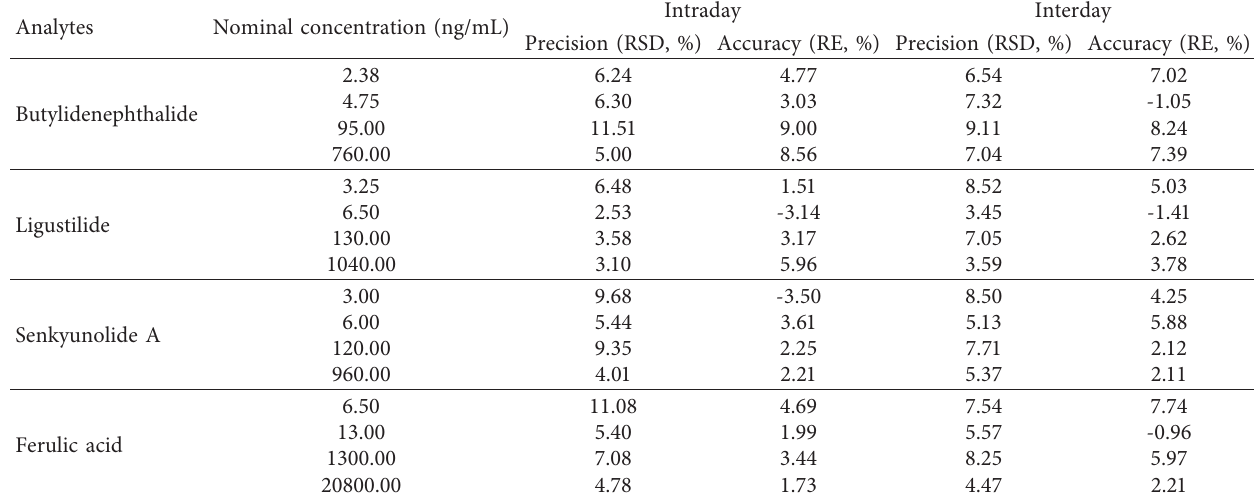
Table 2: Precision and accuracy of butylidenephthalide, ligustilide, senkyunolide A, and ferulic acid in rat plasma (6 replicates per day for 3days).